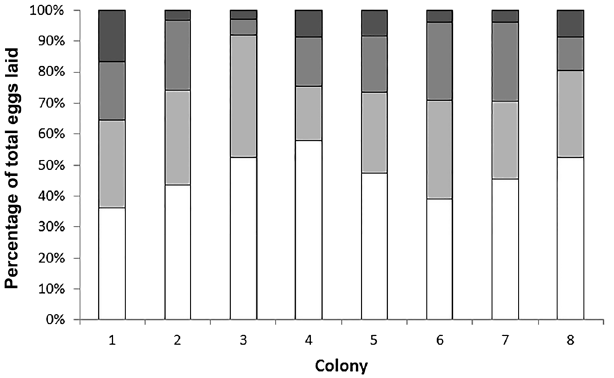
Figure 1. The relative reproductive contributions of the queens (i.e., % of total eggs laid) (n = 32) within each polygynous colony (n = 8). Each queen is represented by a different colour.